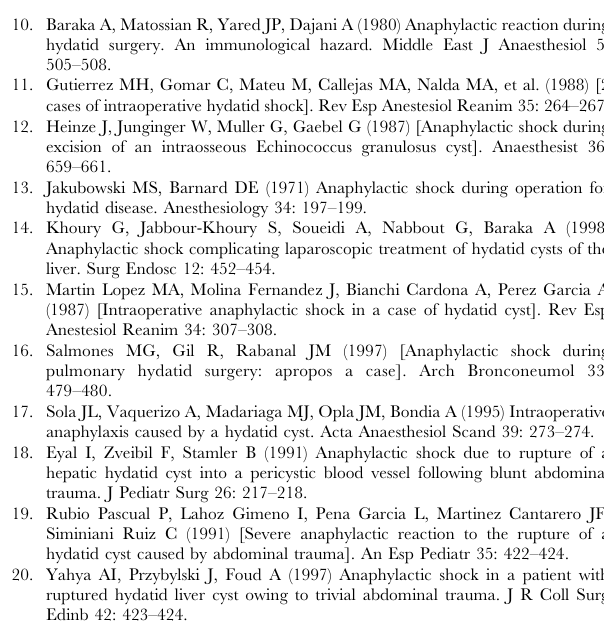
Table S1 Percutaneous treatment of liver hydatid cysts. Table S2 Percutaneous treatment of extra-hepatic hy- datid cysts.